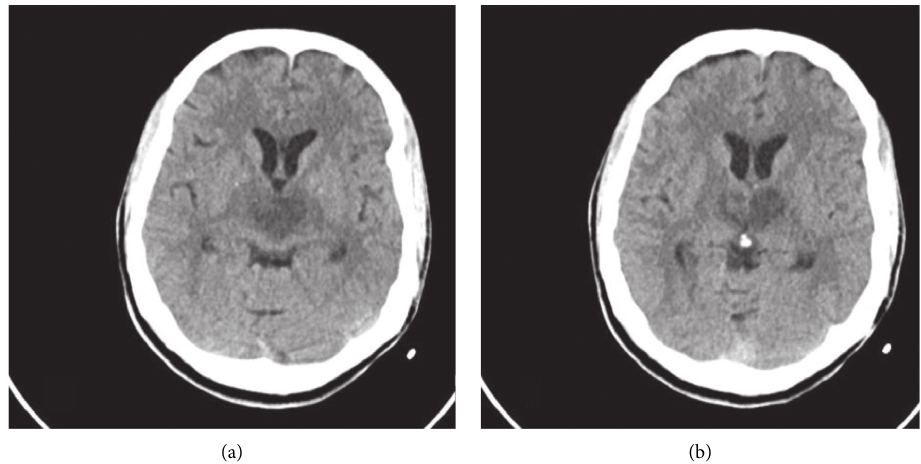
Figure 2: Noncontrast CT brain demonstrating bilateral hypodensities in the medial thalami obtained at the time of admission.